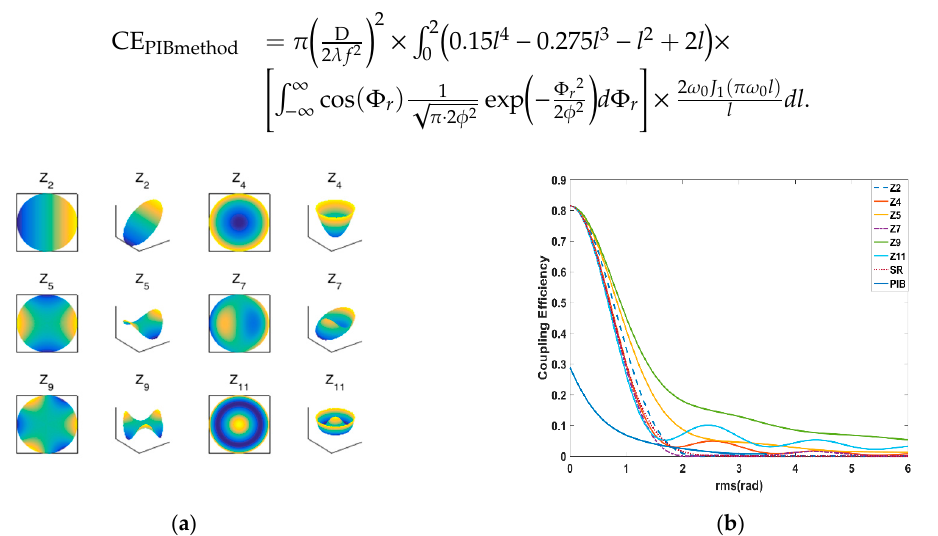
Figure 2. ( a ) Pattern of the first three-order Zernike aberrations; ( b ) coupling efficiency (CE) with the first three-order Zernike aberrations.